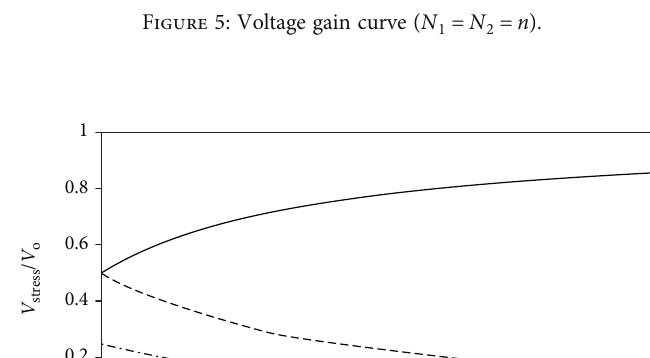
Figure 5: Voltage gain curve ( N